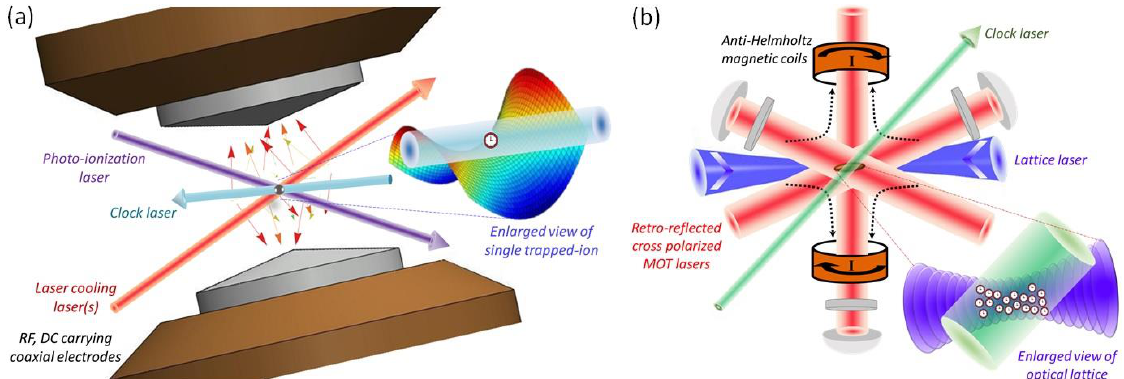
Figure 1. Optical atomic clocks: ( a ) single ion trapped in an end-cap-type Paul trap and ( b ) neutral atoms confined in optical lattices. Enlarged view shows a single ion trapped by an oscillating quadrupole potential and an ensemble of atoms localised in a pancake-shaped 1D optical lattice.